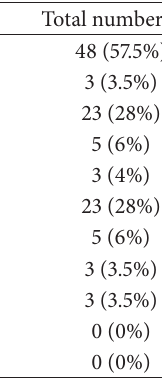
Table 3: Number and percent of 𝛽 -lactamases present in K. pneumoniae collected from Mofid Children and Taleghani Hospitals, Tehran,